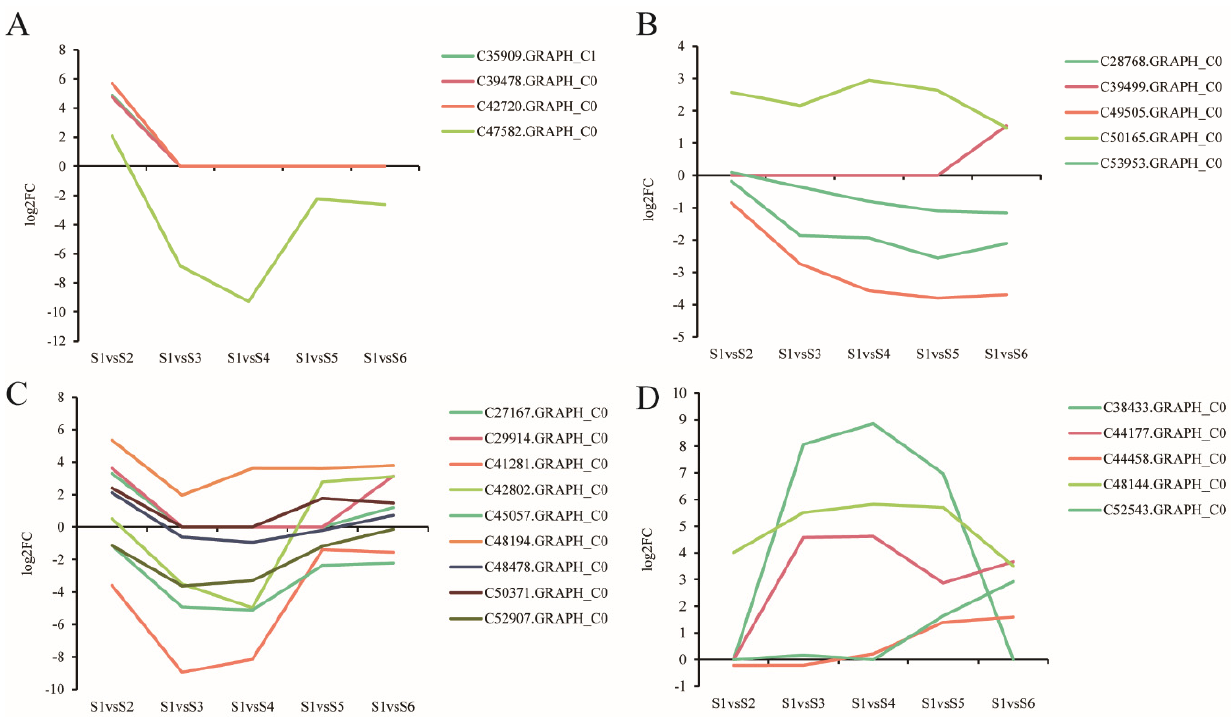
Figure 11. Clustering diagram of peroxidase-related genes based on different log 2 of the fold change variations. ( A – D ) refer to the four subgroups of clustering of peroxidase-related genes.